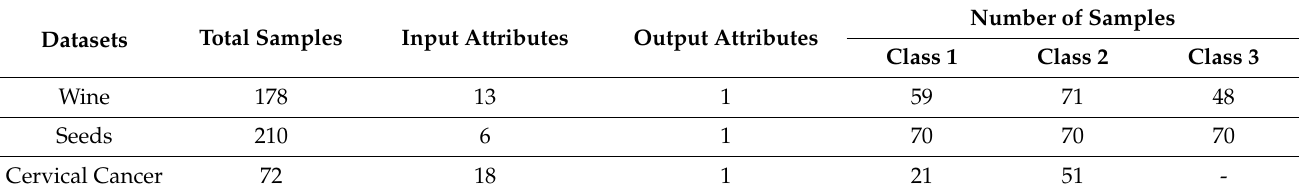
Table 1. Detail of